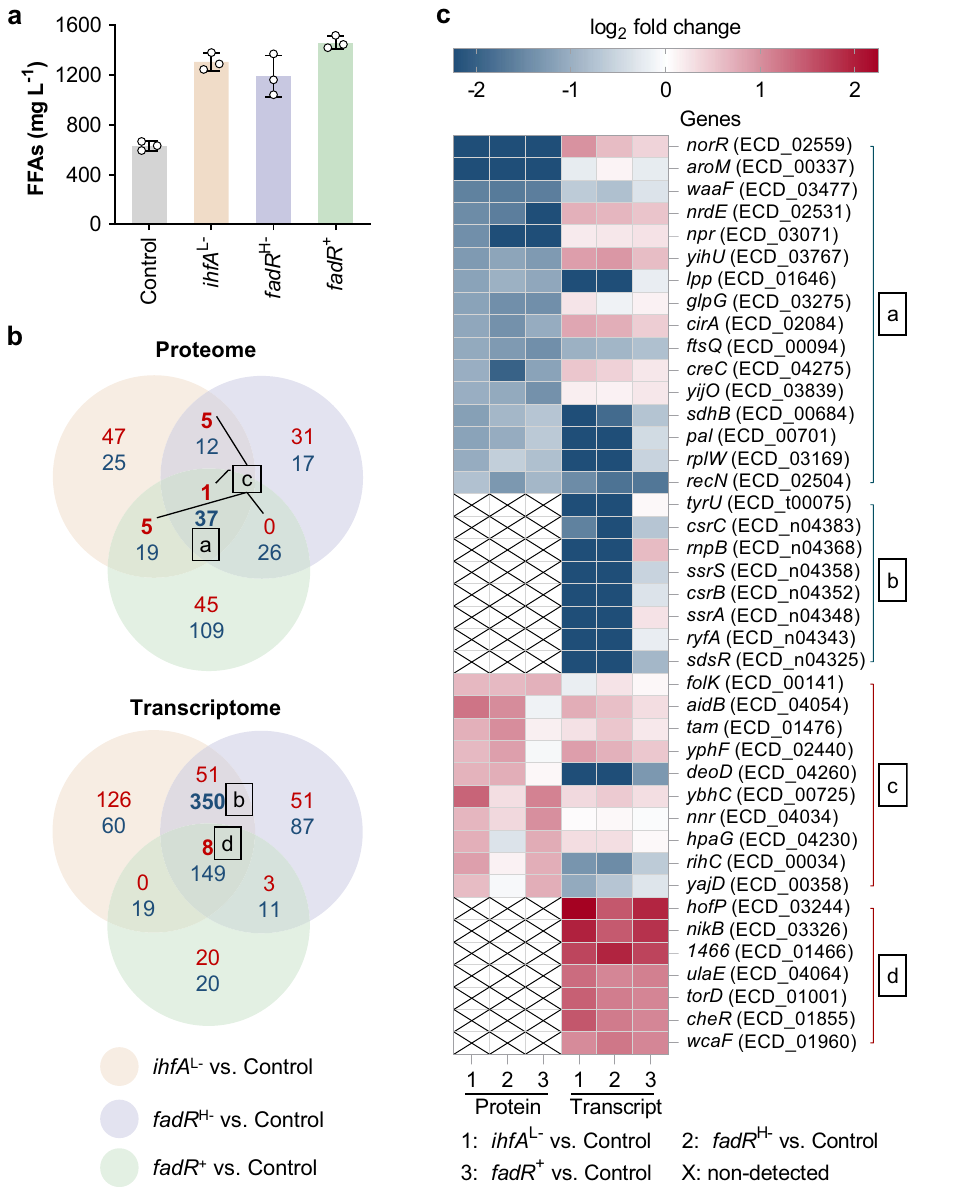
Fig. 4 Proteomic and transcriptomic analyses for exploration of available targets for FFAs production. a FFAs titer of the overproducing strains ihfA L − , fadR H − , and fadR + and the Control strain. The titers were obtained in batch cultivation of 30 g L − 1 glycerol. These strains were applied to the omics analyses. Data are presented as mean ± SD ( n = 3 biological replicates). b Venn diagram of differentially expressed genes. Blue numbers, genes expressed with decreased abundance; red number, genes expressed with increased abundance. Genes in sets a, b, c, and d had decreased abundance at the protein level, decreased abundance at the transcript level, increased abundance at the protein level, and increased abundance at the transcript level, respectively, in at least two FFAs-overproducing strains compared with the Control strain. c Abundance of the selected candidate genes at the protein and transcript levels. 1466 represents the gene numbered ECD_01466 in BL21(DE3). Genes in sets a, b, c, and d were selected from sets a, b, c, and d in ( b ). Source data are provided as a Source Data fi